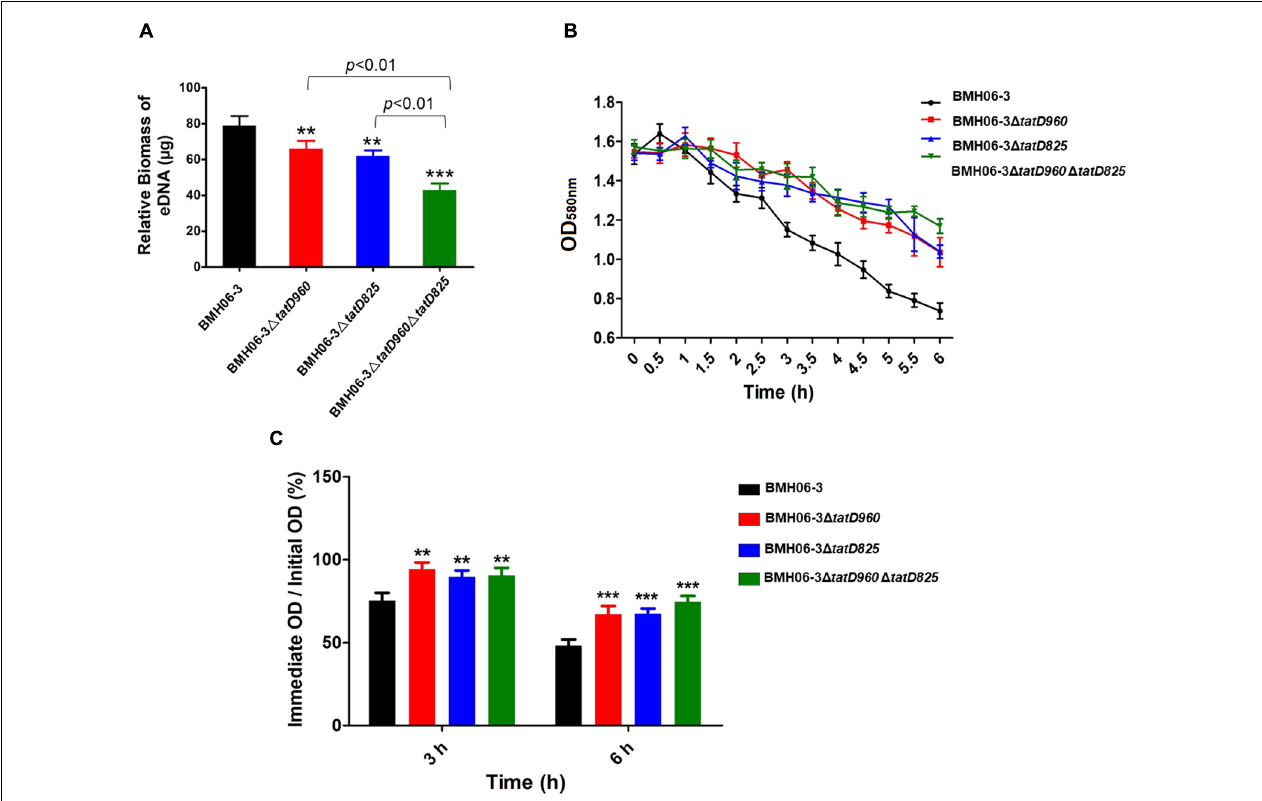
FIGURE 6 | The reduction in biofilm formation in tatD -deficient mutants may be associated with the reduced autolysis and relative eDNA content in the biofilm. (A) The EPS of T. pyogenes biofilm were extracted. Relative eDNA in the EPS was quantified using the PicoGreen assay. (B) The autolytic ability of T. pyogenes was detected by treatment with 0.1% Triton X-100 and measuring the OD 580 nm value. (C) tatD deficiency reduces the autolytic ability of T. pyogenes . The wild-type strain BMH06-3 was used as a control group. Statistical analysis was carried out using one-way of variance (ANOVA) on SPSS Statistics V17.0. Statistical significance compared with the control group was defined as ** p < 0.01 and *** p < 0.001.